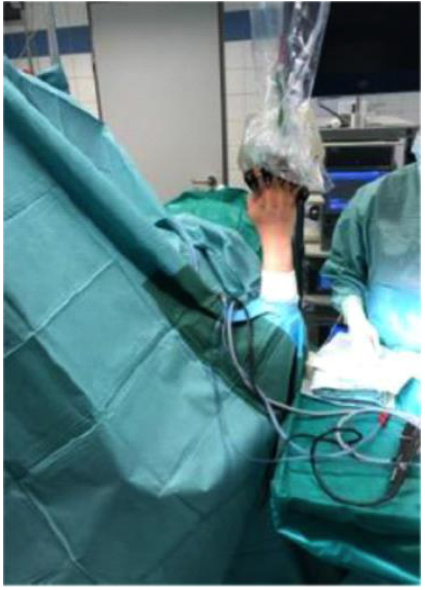
Figure 1. Construction arthroscopy.